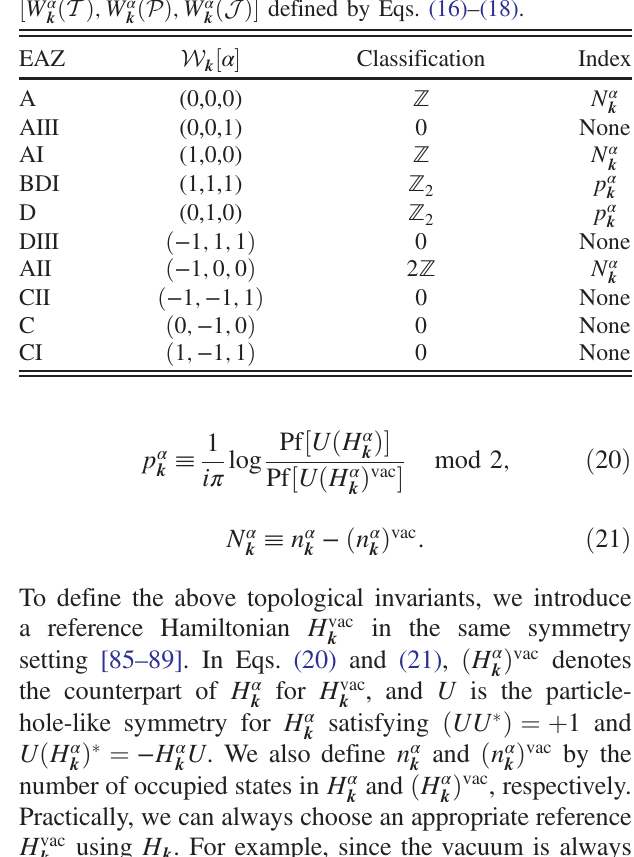
TABLE II. The classification of zero-dimensional topological phases for each EAZ symmetry class. Topological indices p α N α in the table are defined by Eqs. (20) and (21). Here, W ½ α (cid:2) k represents the triple of the result of Wigner